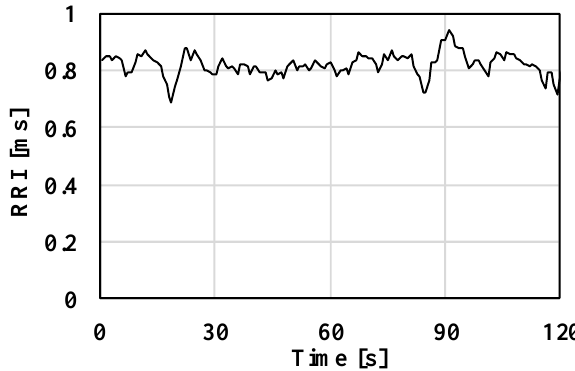
Figure 4. Time history of the R-R interval (RRI).